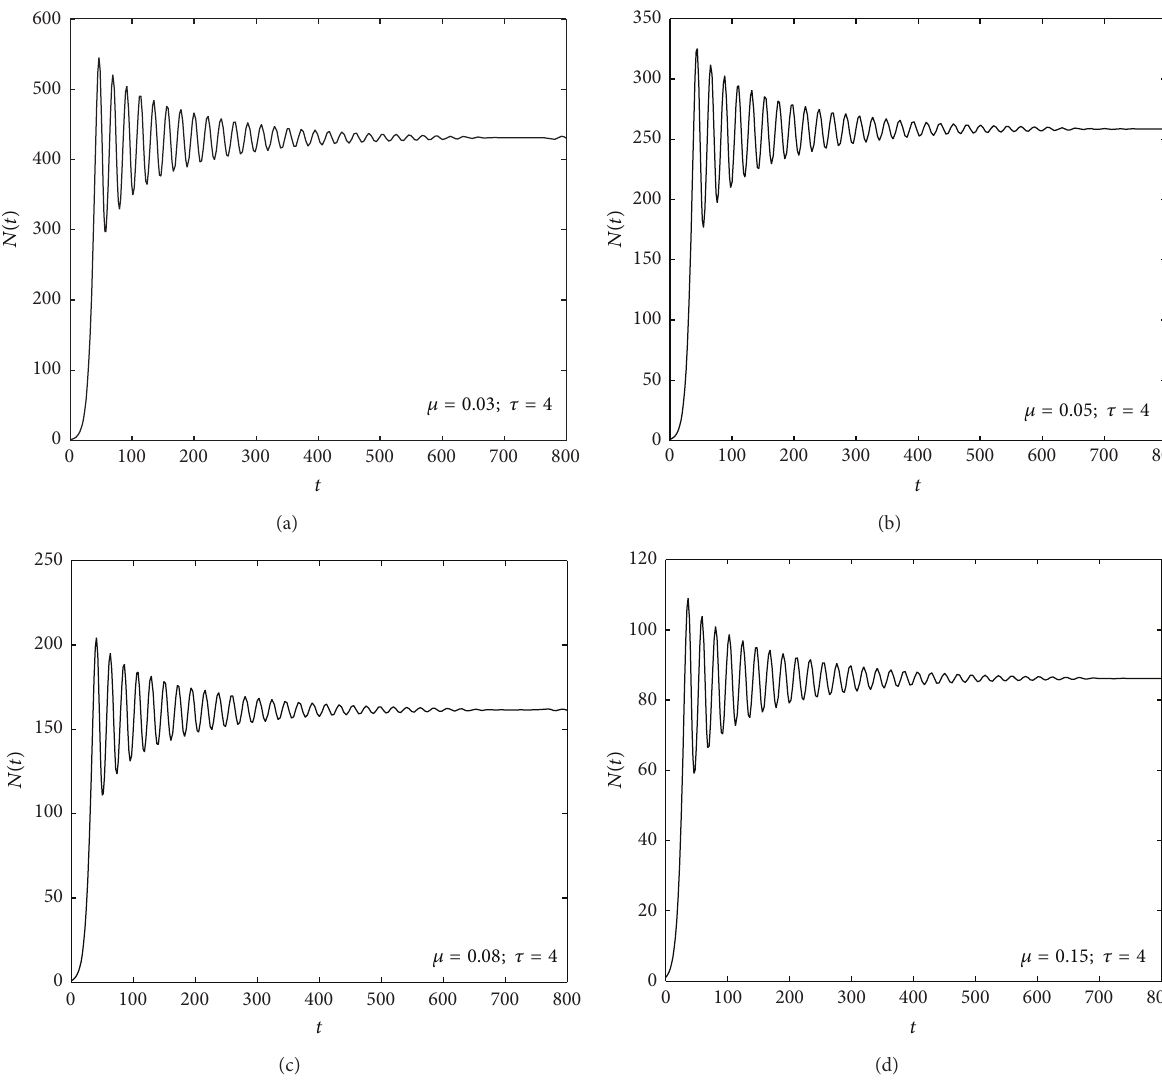
Figure 3: Time process diagrams of credit risk contagion in the financial market under the influence of the nonlinear resistance coefficient 𝜇